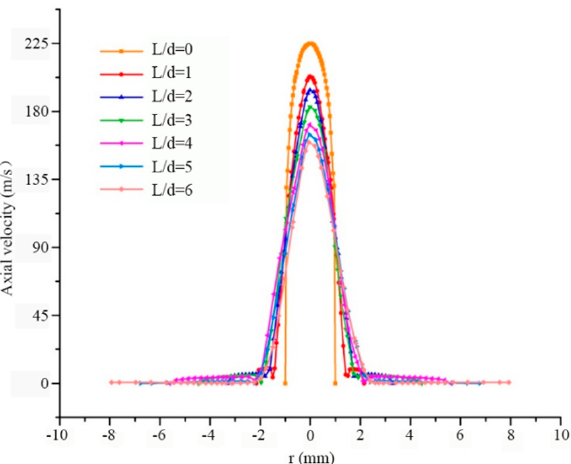
Figure 5. Axial velocity distribution under variant dimensionless jetting distances.